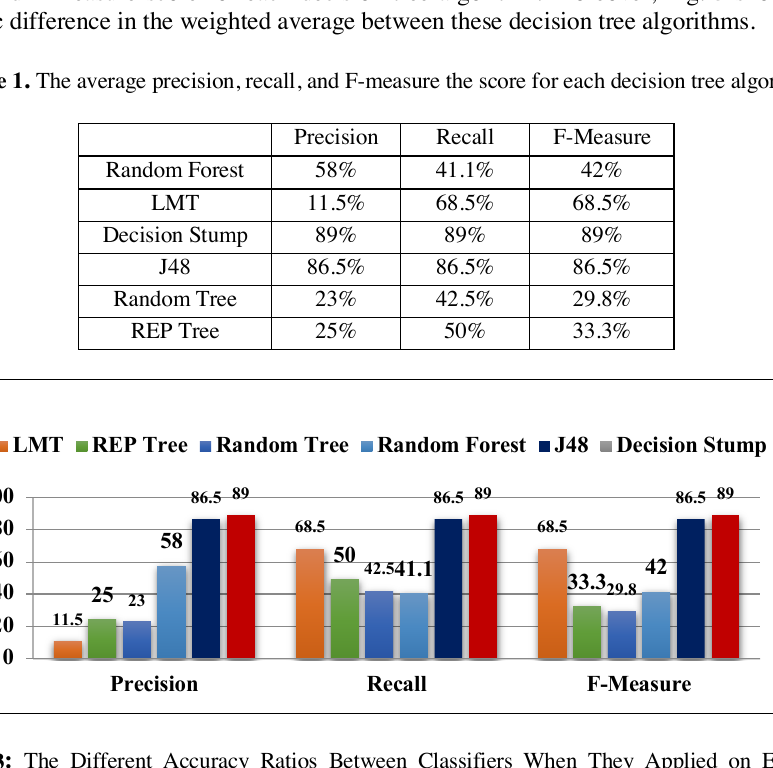
: The Different Accuracy Ratios Between Classifiers When They Applied on Emails